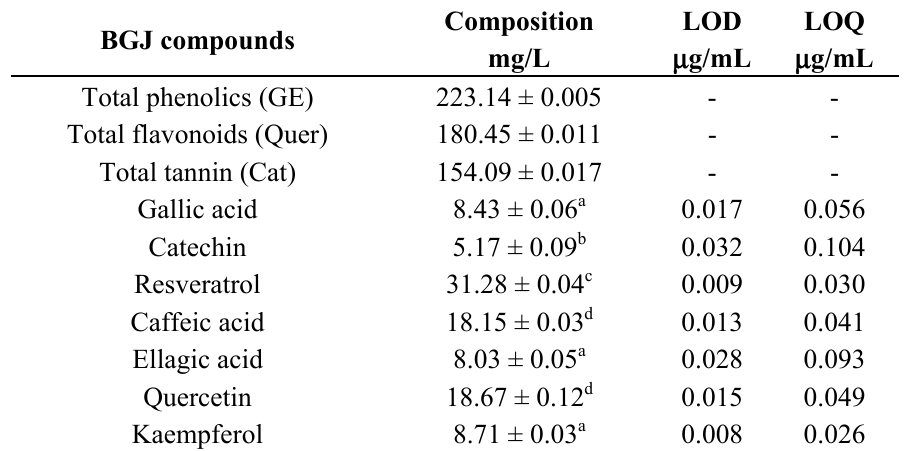
Table 1. Content of phenolics, flavonoids and condensed tannins of BGJ. LOD and LOQ variations for antioxidants